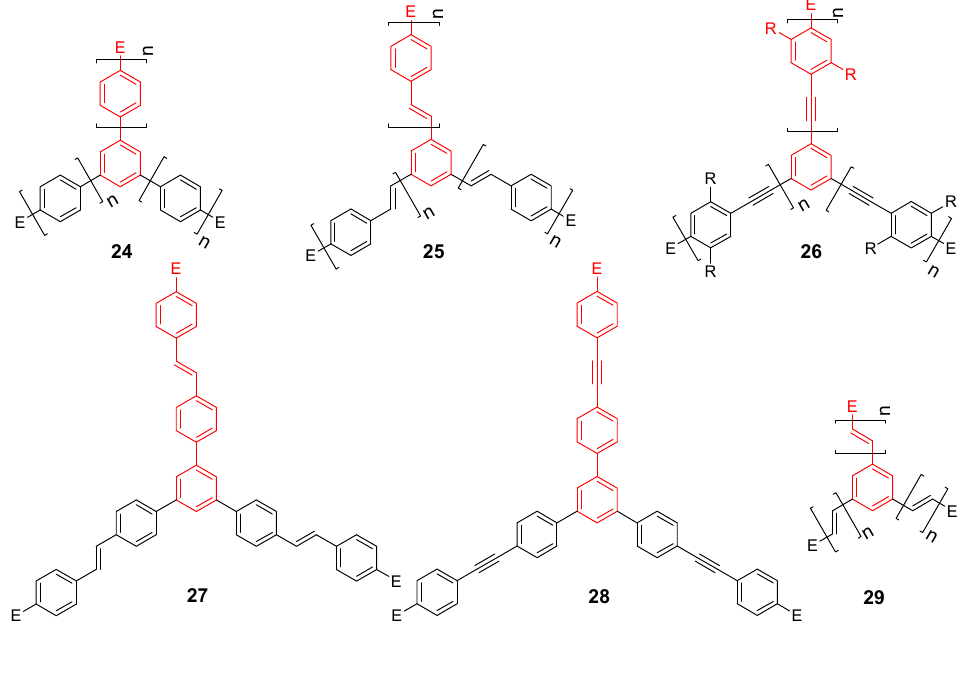
Figure 10. Parent three-arm stars with a 1,3,5-substituted benzene core